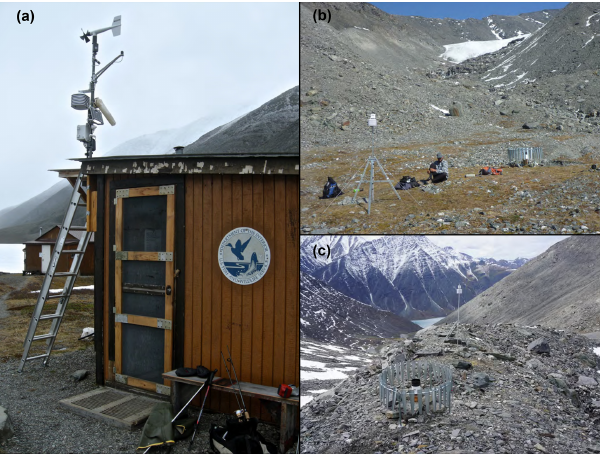
Figure 3. Weather stations at (a) 850, (b) 1425, and (c) 1750ma.s.l. in the Lake Peters watershed.